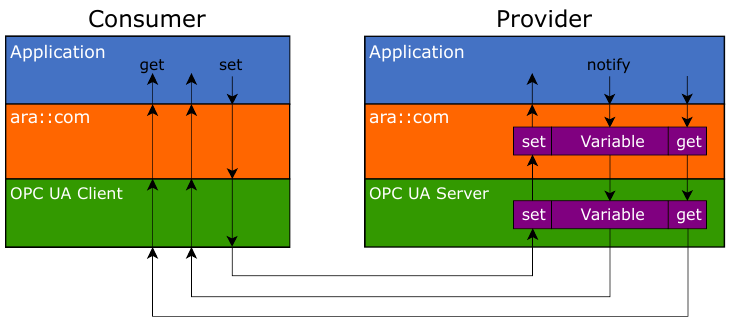
Figure 9. Field mapping